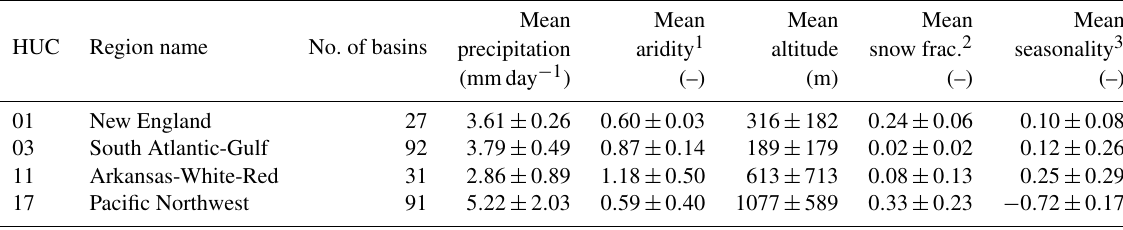
Table 1. Overview of the HUCs considered in this study and some region statistics averaged over all basins in that region. For each variable mean and standard deviation is reported.